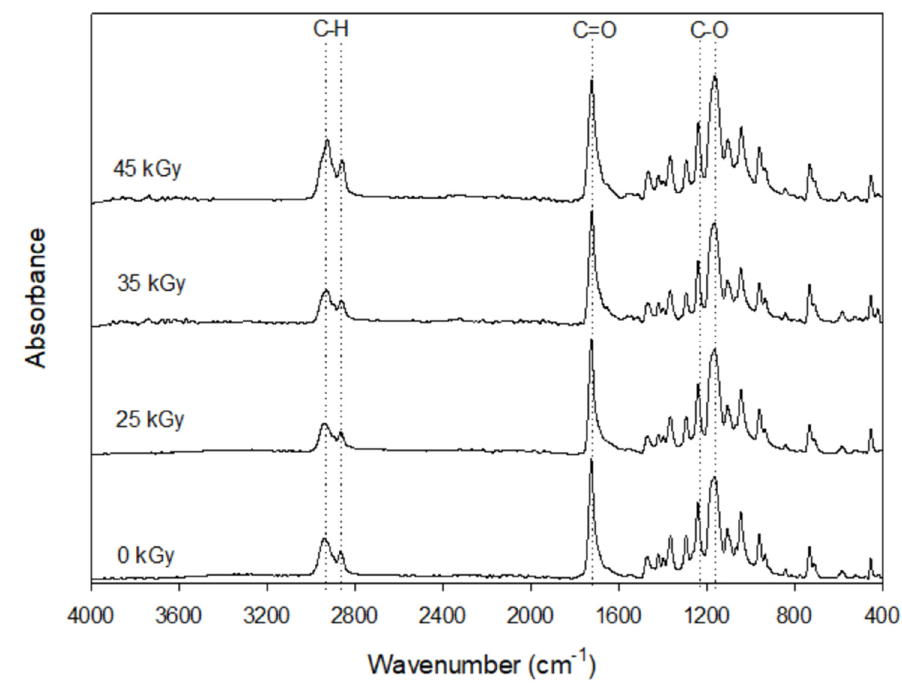
Figure 1. FTIR spectra of PCL scaffolds sterilized with different gamma radiation conditions.